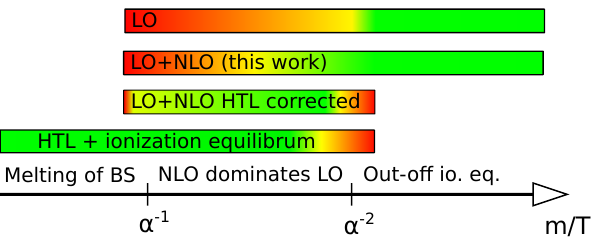
Figure 10 . Illustration of the goodness of di(cid:11)erent descriptions, based on the assumption that the mediator is (unsuppressed) coupled to the primordial plasma background. LO and LO+NLO indicate bound-state formation via LO emission of an on-shell mediator only or including higher order contributions to the photon spectral function, respectively. The bottom bar represents HTL resummed corrections to the Sommerfeld enhanced annihilation and bound-state decay rate under the assumption of ionization